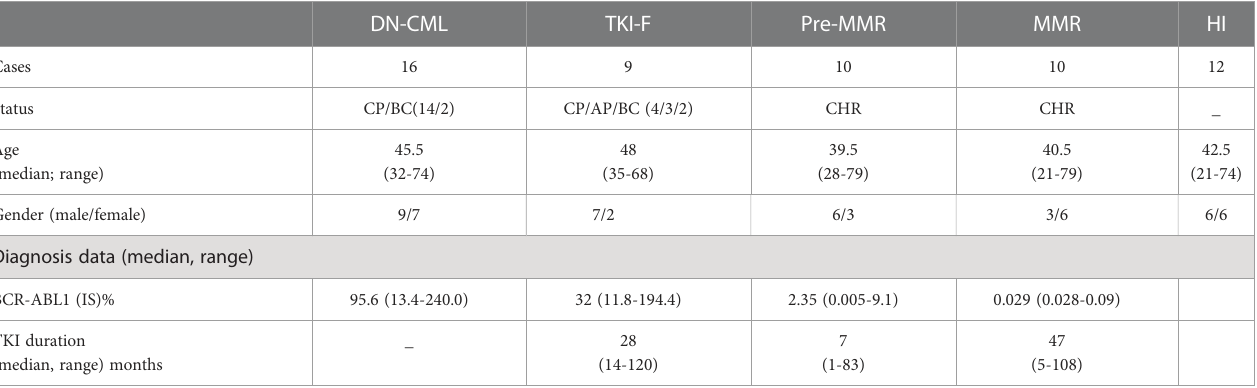
TABLE 1 Peripheral blood sample